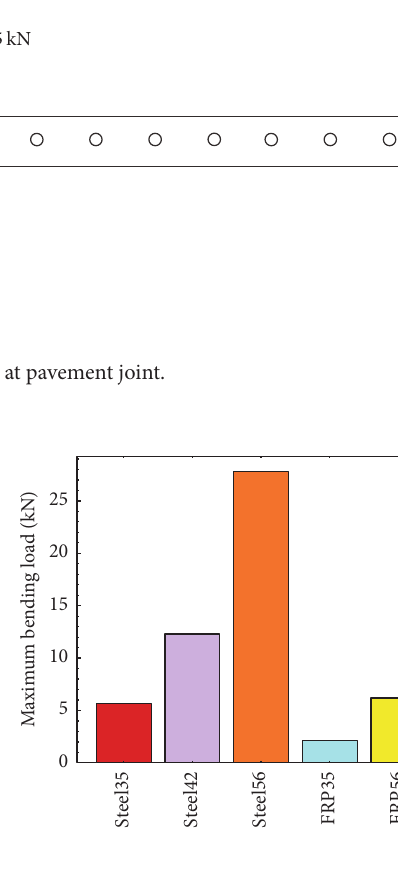
Figure 3: Maximum bending load for different dowels.